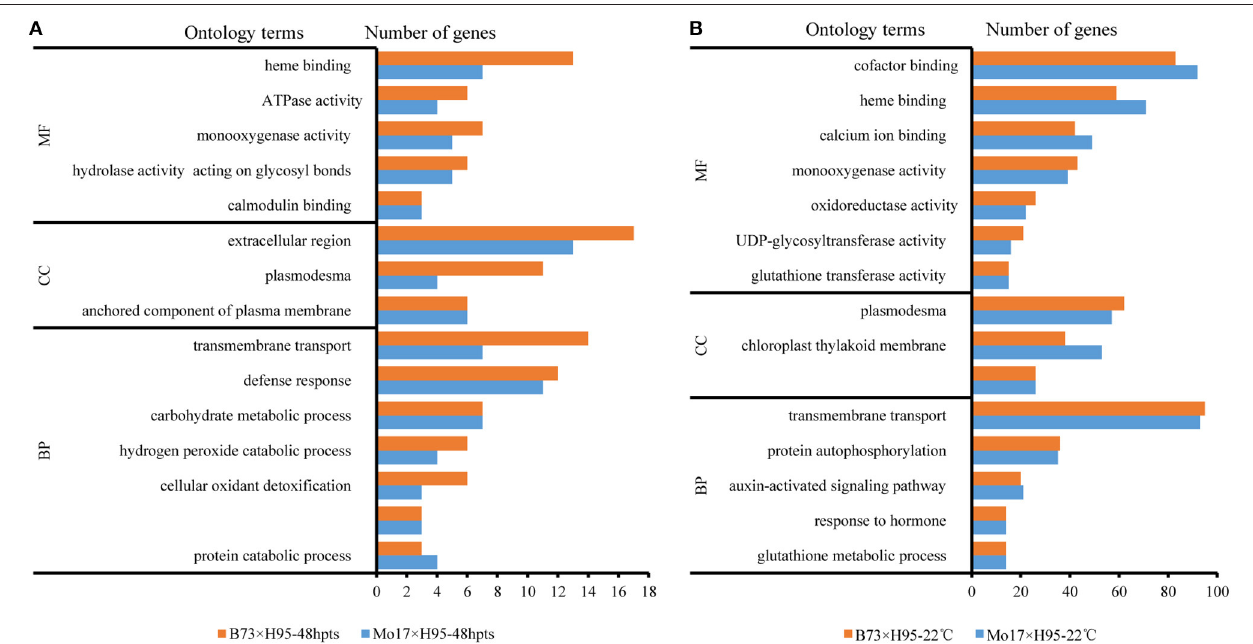
FIGURE 2 | The Gene ontology (GO) enrichment of differentially expressed genes (DEGs) in maize Rp1-D21 mutant (mt) compared to the wild type (WT) for the indicated times. (A) Top 15 GO subcategories of DEGs from Rp1-D21 mt in B73 × H95 and Mo17 × H95 backgrounds at 48 hours post temperature shift (hpts). (B) Top 15 GO subcategories of DEGs from Rp1-D21 mt in B73 × H95 and Mo17 × H95 backgrounds at constant 22 ◦ C. MF, molecular function; CC, cellular component; BP, biological